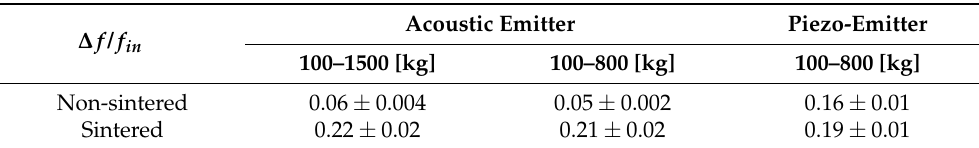
Figure 10. Dependence of the resonance frequency in the function of load for non-sintered and sintered sample determined with the use of piezo-emitter. Green and blue curves correspond to the subsequent measurements. Table 3. Relative change of resonant frequency versus load determined by SAS working in two configurations with acoustic and